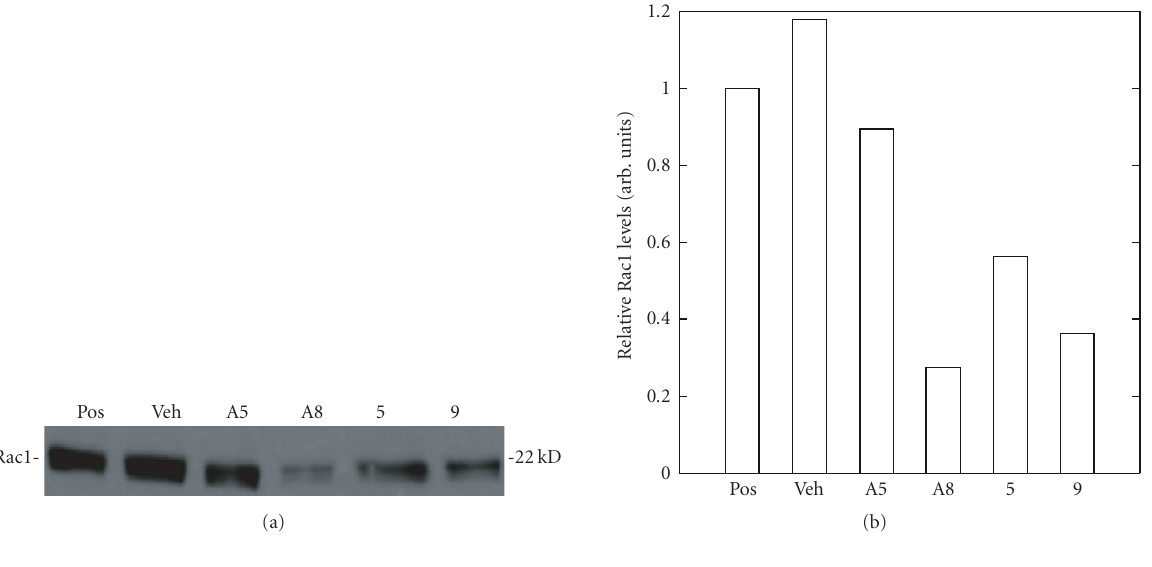
Figure 5: (a) Western blot of MDA-MB 435 breast cancer cells cultured on fibronectin for 1hour. Active Rac1 was isolated using a PAK-PBD pull down assay. Positive control (lane 1) and ethanol control (lane 2) were compared to cells treated with 36 ng/ μ L of either compound A5, A8, 5, or 9 (lanes 3, 4, 5, and 6, resp) by probing with a monoclonal antibody for Rac1. (b) Densitometric analysis of Rac1 band